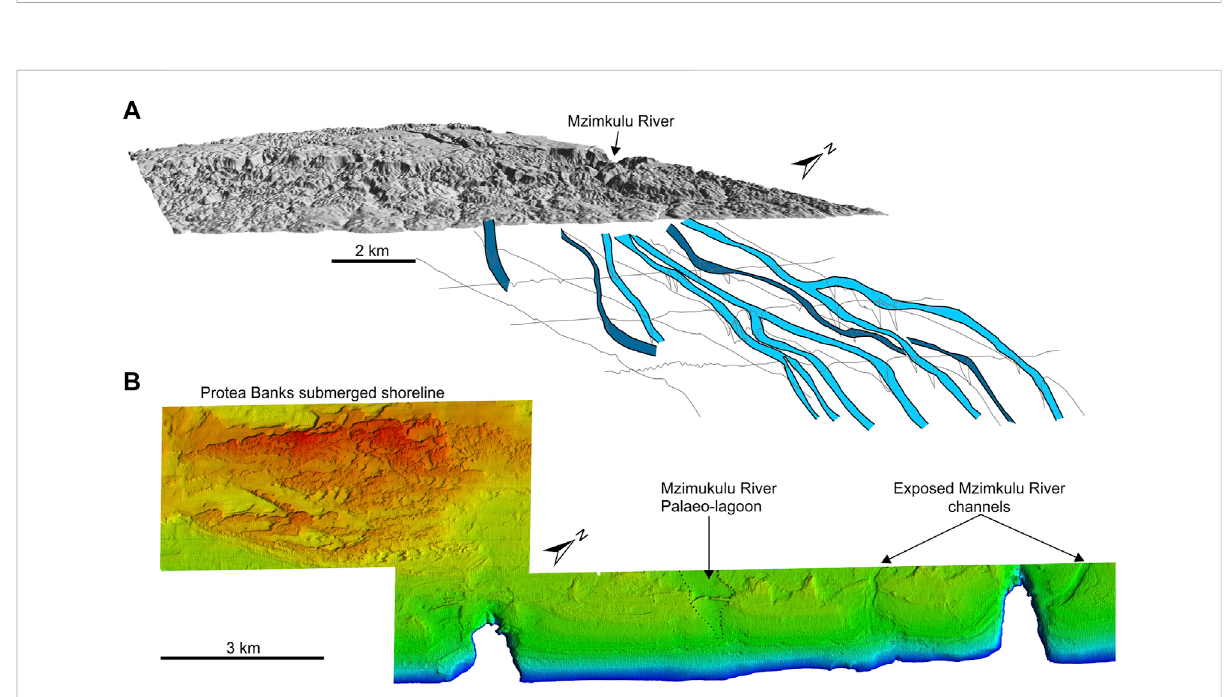
FIGURE 7 (A) 3D representation of the drainage pattern offshore the Mzimkulu River, just to the north of Mpondoland. Dark blue represents an older subaerialchannelnetwork,likelyMIS6,thelighterbluerepresentstheLGMdrainagesystem(afterPretoriusetal.,2019). (B) Multibeambathymetryof the Protea Banks shelf immediately offshore the Mzimkulu River. Note the development of a lagoon, with several LGM channels still exposed at the seabed, one of which entering a submarine canyon and likely forming a waterfall akin to the Waterfall Bluff site of